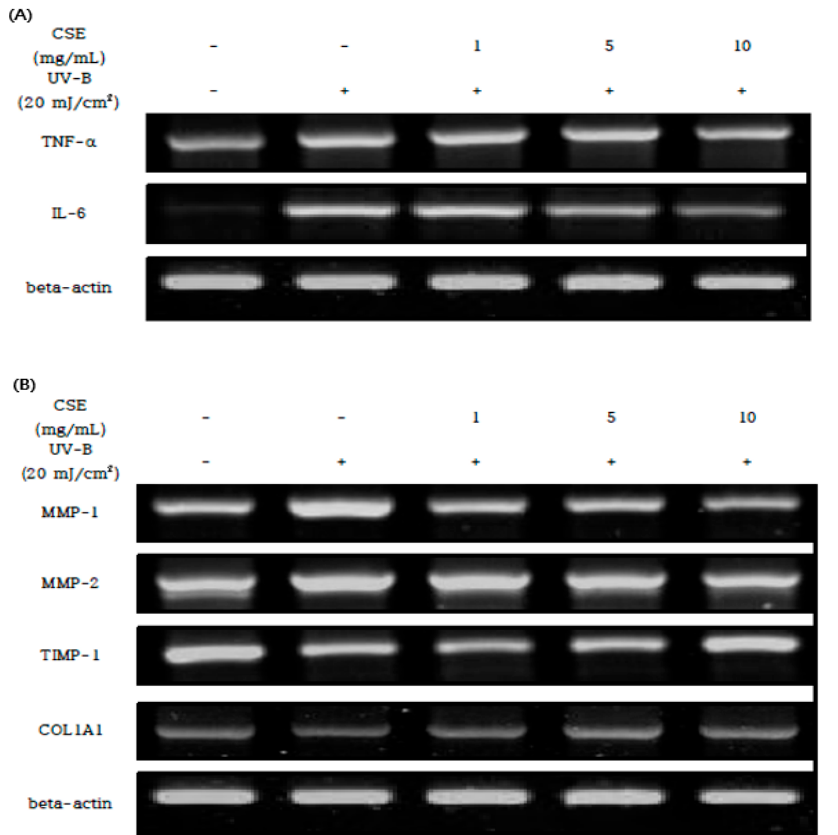
Figure 5. Effects of the CSE on the expression of inflammatory and photo-aging in HDFs cells. RT- PCR analysis of mRNA expression levels of inflammatory ( A ) and photo-aging ( B ). Total RNA was isolated from the HDFs cells of the normal, UV-B, and CSE (1, 5 and 10 mg/mL) groups for RT-PCR analysis at 24 h. Total RNA was isolated and quantified by beta-actin for quantitative comparison.